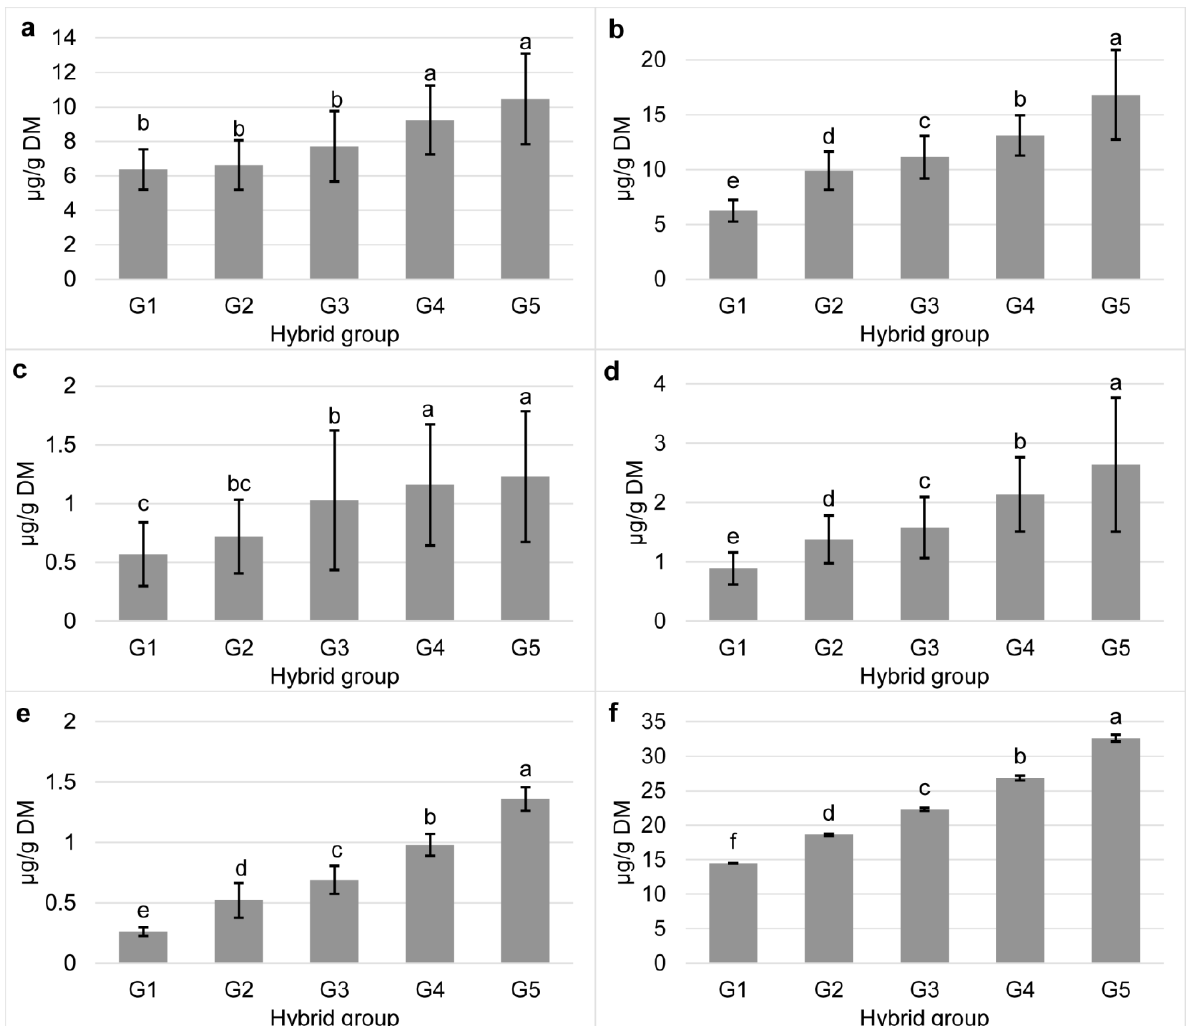
Figure 1. Content of individual ( a ), lutein; ( b ), zeaxanthin; ( c ), α-cryptoxanthin; ( d ), β-cryptoxanthin; ( e ), β-carotene) and total carotenoids ( f ) of commercial maize hybrids classified into five groups according to the total carotenoid content (G1, <15; G2, 15–20; G3, 25–25; G4, 25–30, and G5, >30 µg/g DM). Different small letters represent statistically significant differences ( p < 0.05) between hybrid groups. Error bars represent SD.